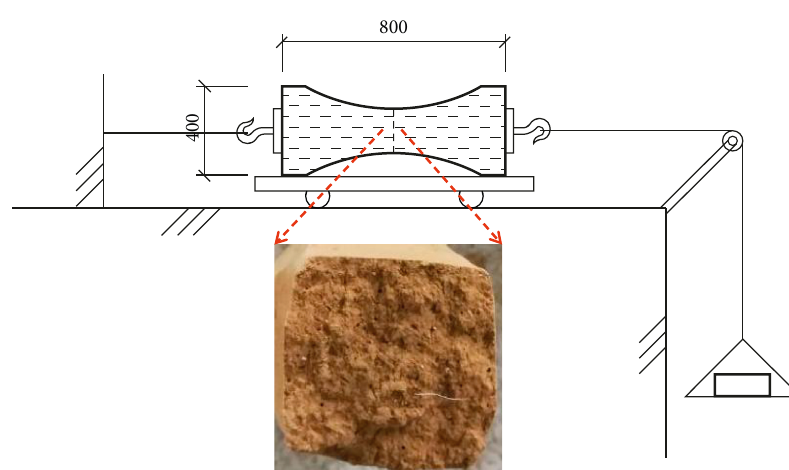
Figure 9: The diagram of tension test for sample of 0 °